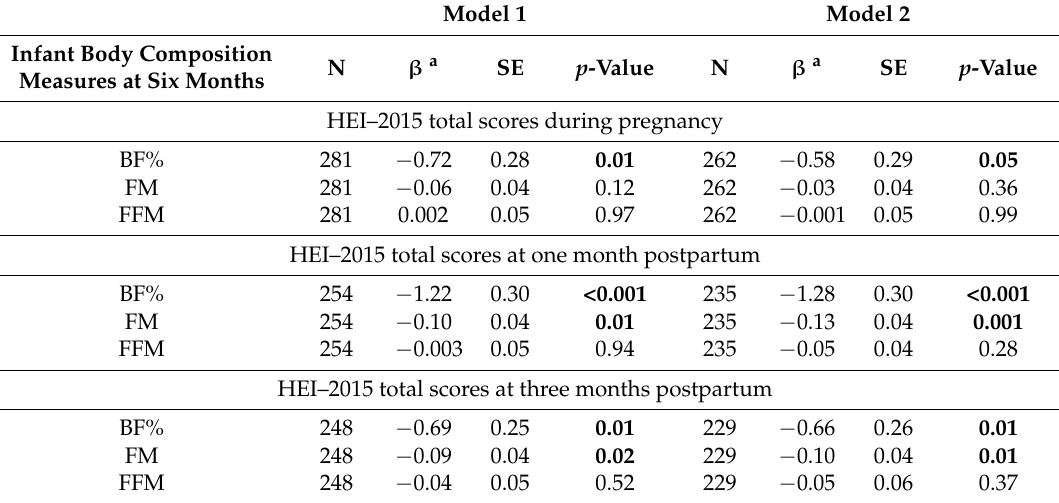
Table 4. Associations of HEI–2015 total scores during the third trimester of pregnancy and at one and three months postpartum with infant body composition at six